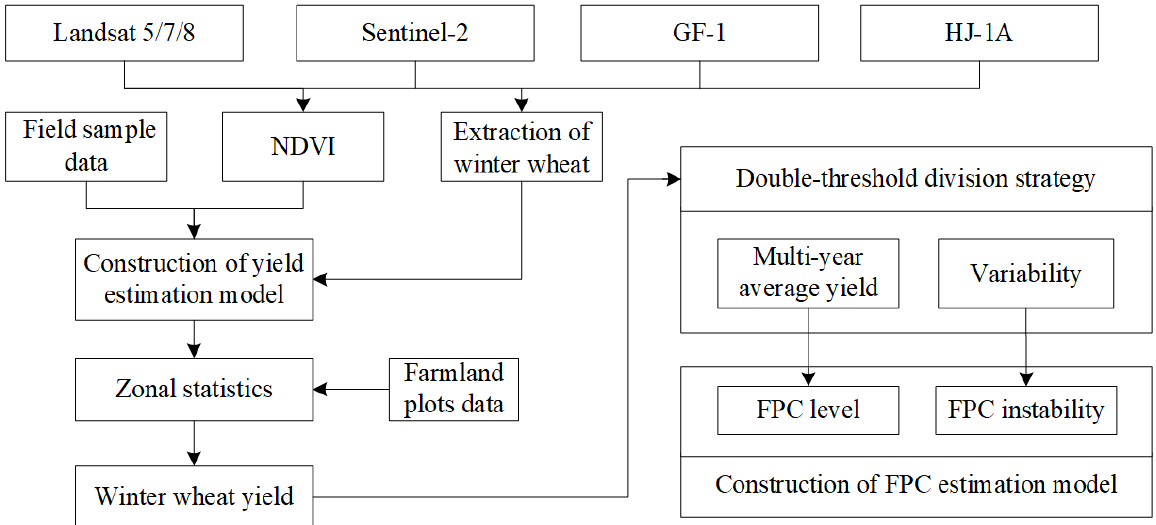
Figure 4. Flowchart of the methods.